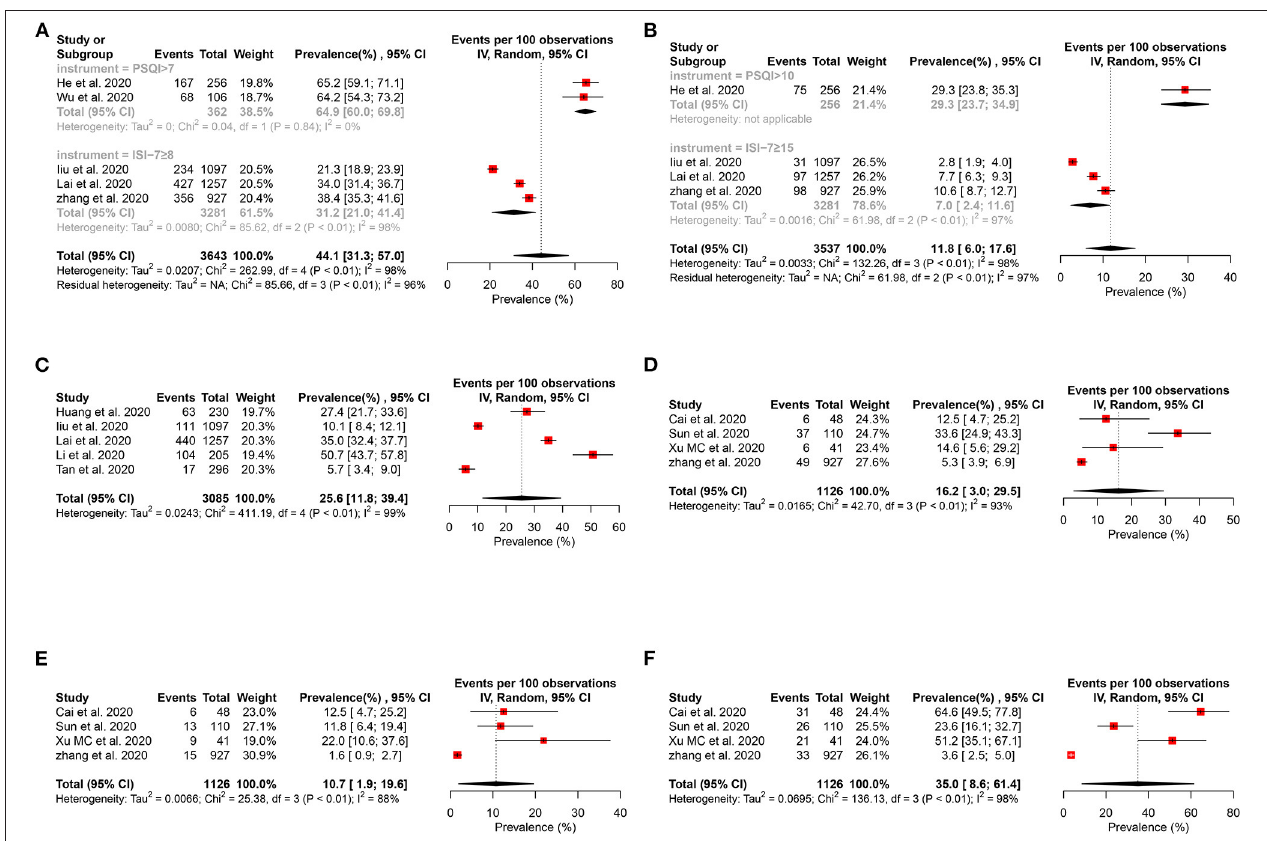
FIGURE 7 | Forest plot for the meta-analysis of the prevalence of other mental health problems among healthcare workers. (A) Forest plot of the prevalence of insomnia. (B) Forest plot of the moderate to severe insomnia. (C) Forest plot of the prevalence of distress. (D) Forest plot of the prevalence of obsessive–compulsive symptoms. (E) Forest plot of the prevalence of somatization symptoms. (F) Forest plot of the prevalence of